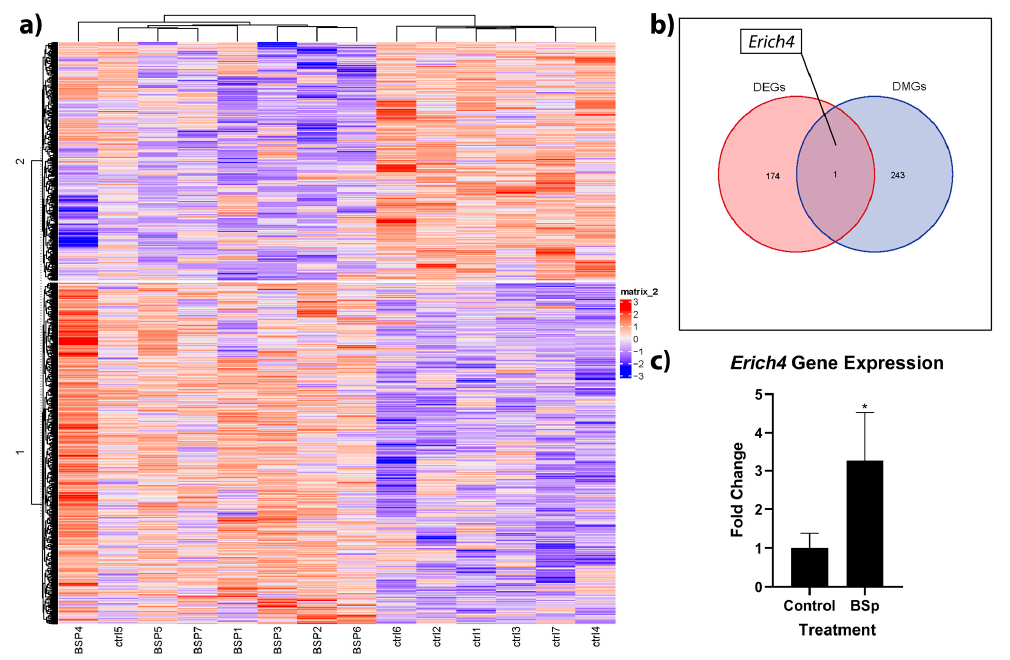
Figure 6. Heatmap of differentially methylated genes within breast tumor samples of BSp-treated mice vs. controls ( a ), as well as subsequent Venn diagram ( b ) of overlap between